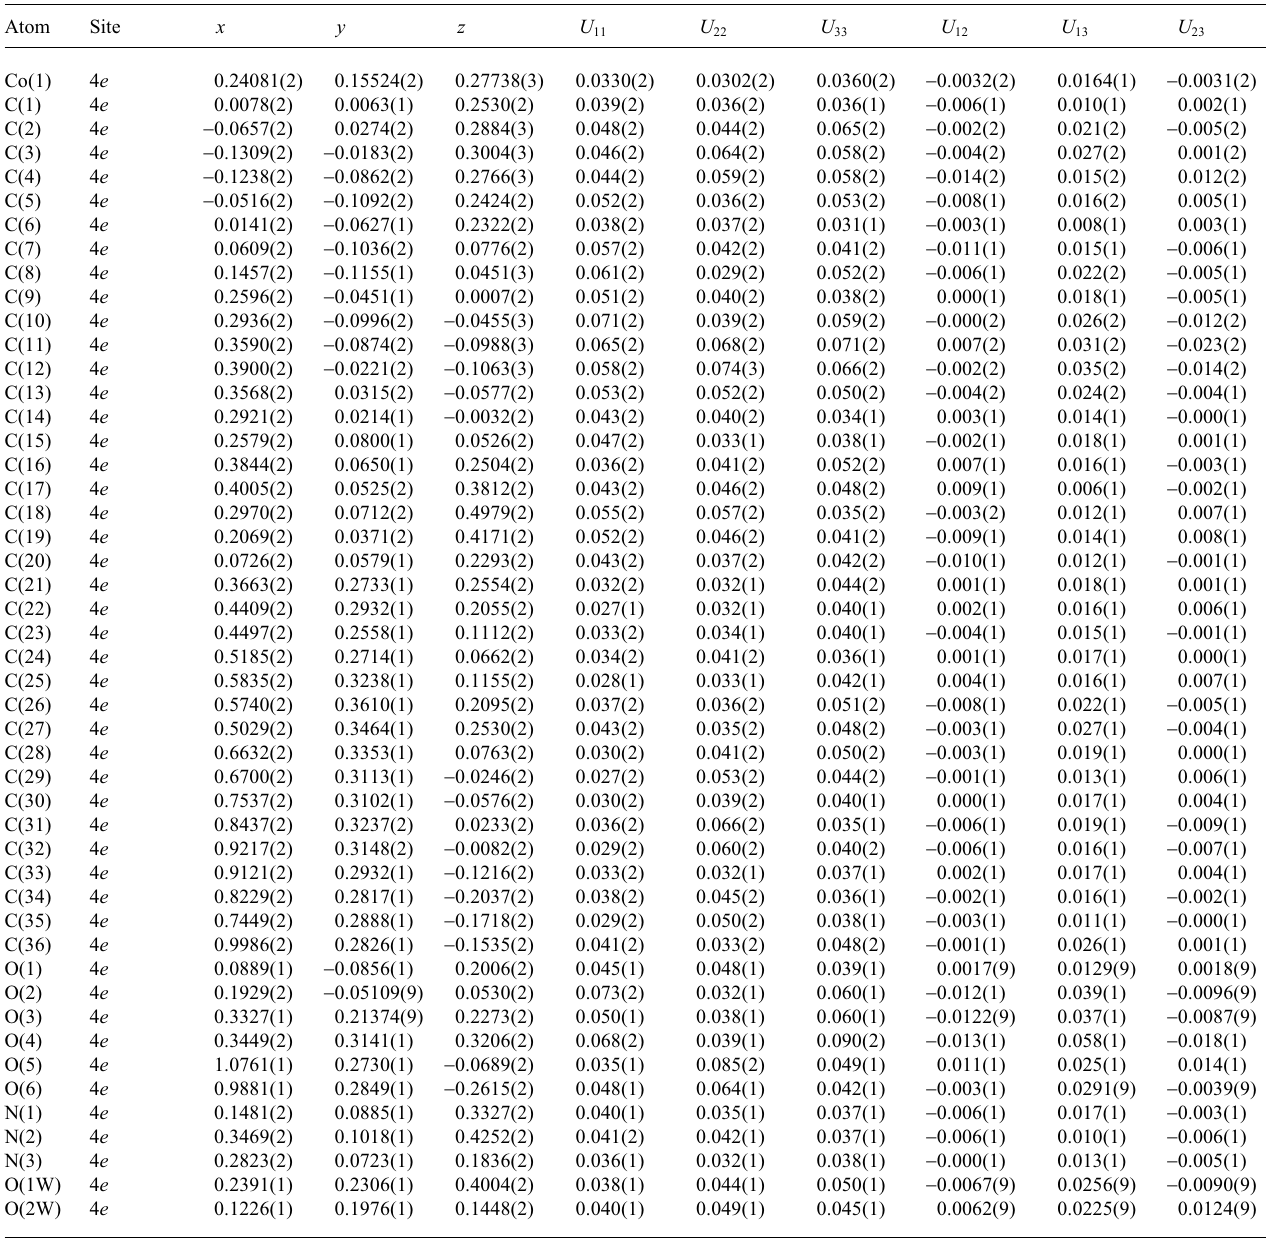
Table 3. Atomic coordinates and displacement parameters (in Å 2